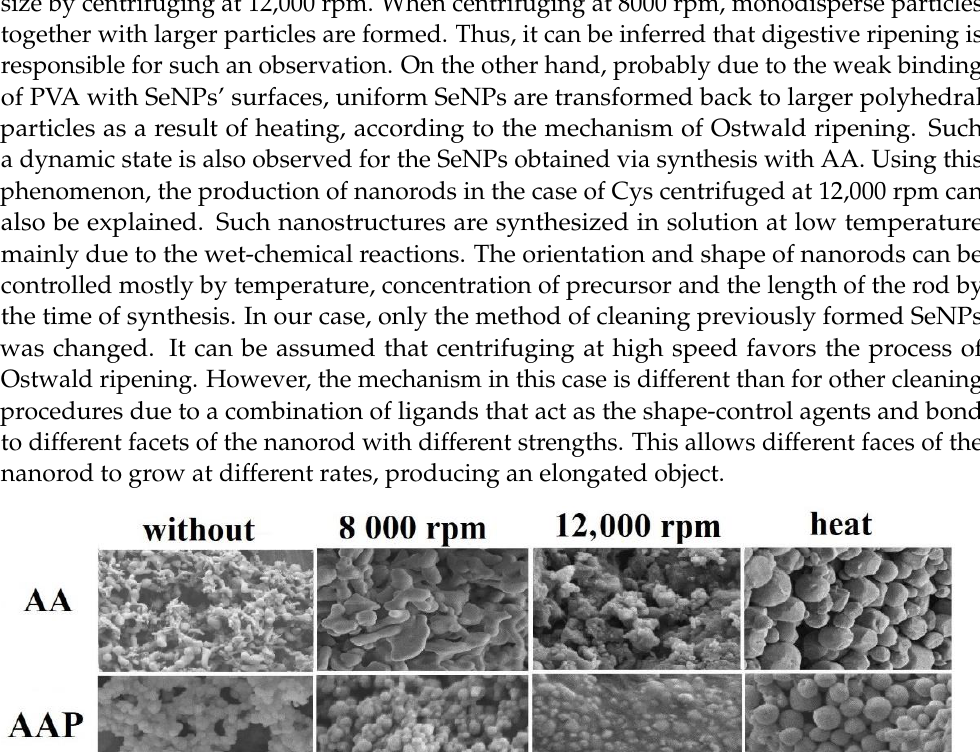
Figure 7. TEM images of the obtained SeNPs.